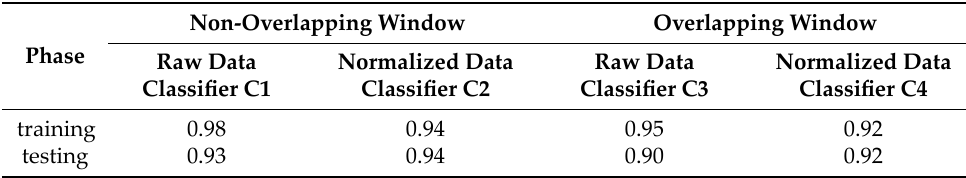
Table 7. The accuracies of training and testing phases for obtained classifiers.